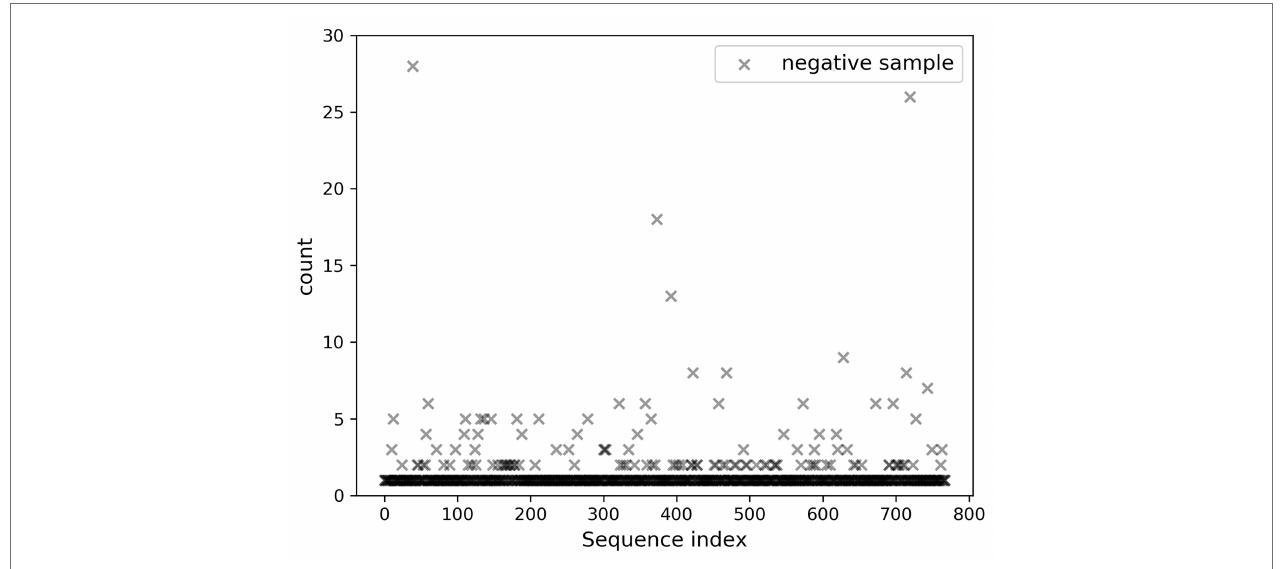
FIGURE 10 | Display of negative sample expression.